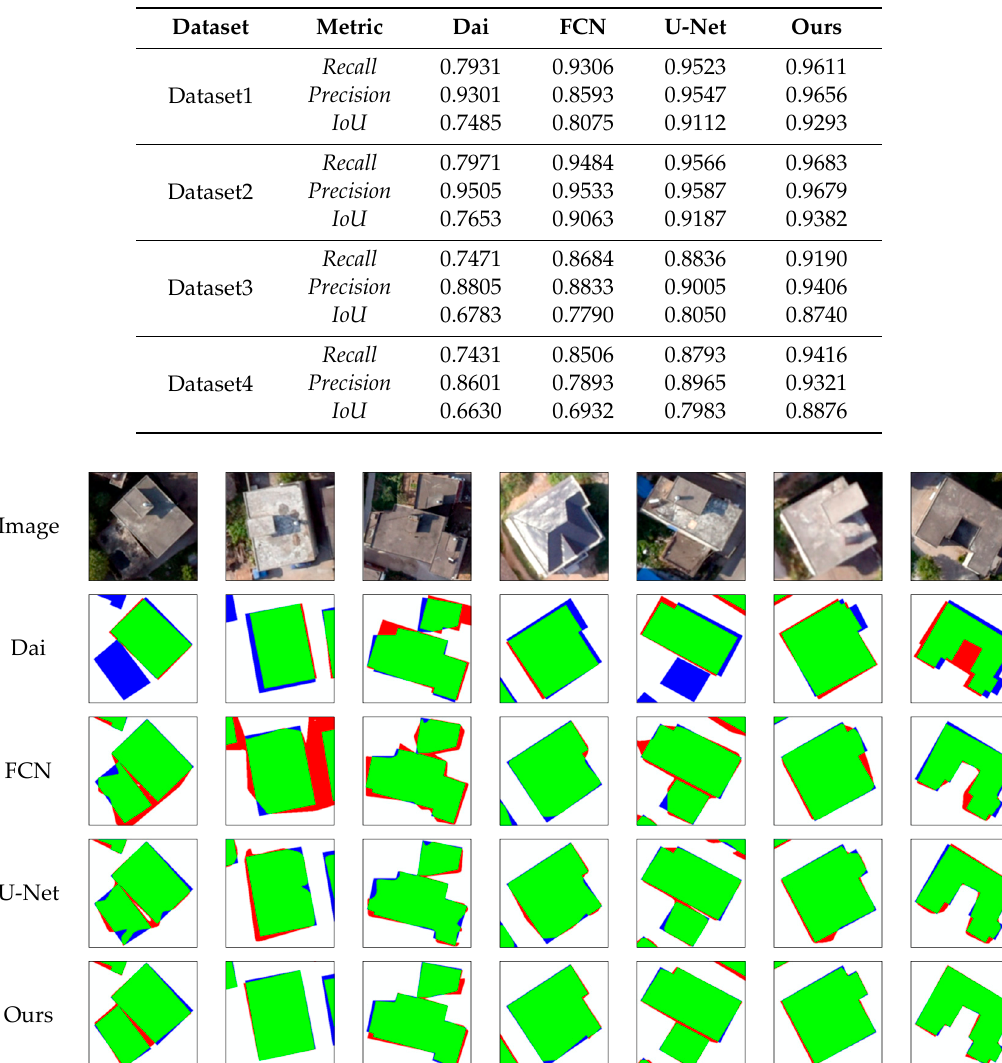
Table 6. Recall , Precision , and IoU values of Dai’ s method, FCN, U-Net, and our method in the four datasets.